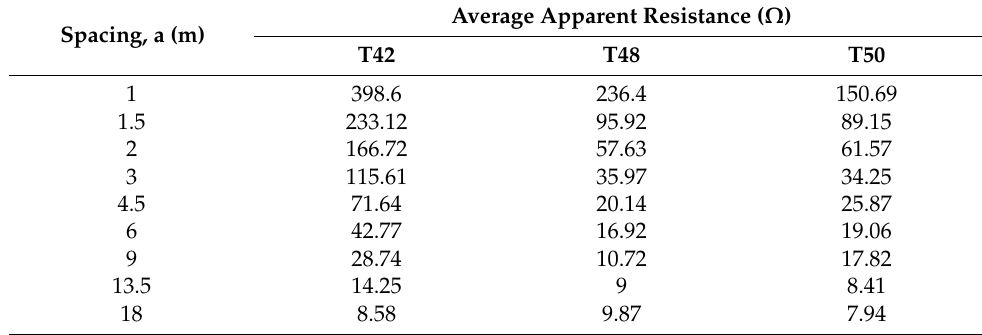
Average Apparent Resistance ( Ω